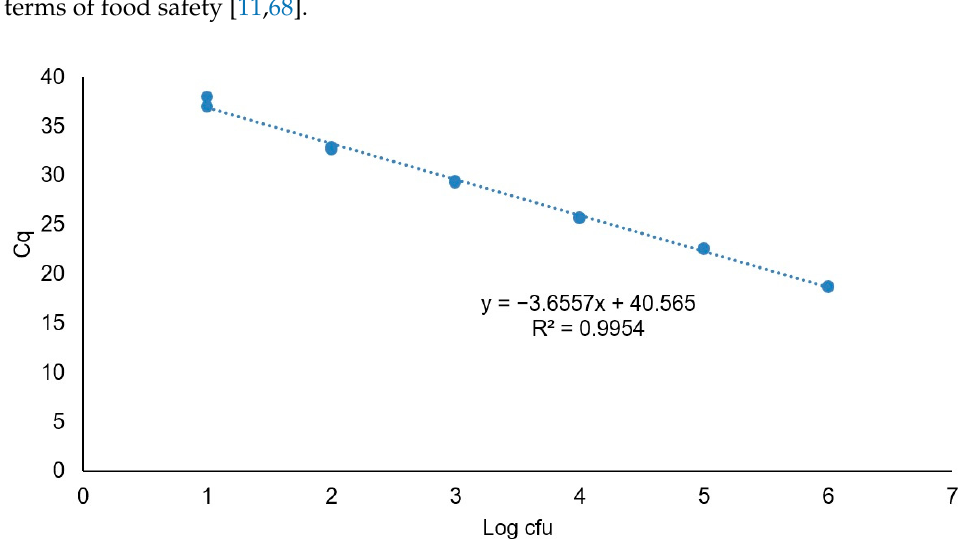
Figure 3. Standard curve of the 124 bp iap gene fragment of L. monocytogenes CECT 935 obtained with quantification cycle (Cq) plotted against the logarithmic concentration of the serial dilutions. The trend line equation and corresponding square regression coefficient ( R 2 ) are shown.